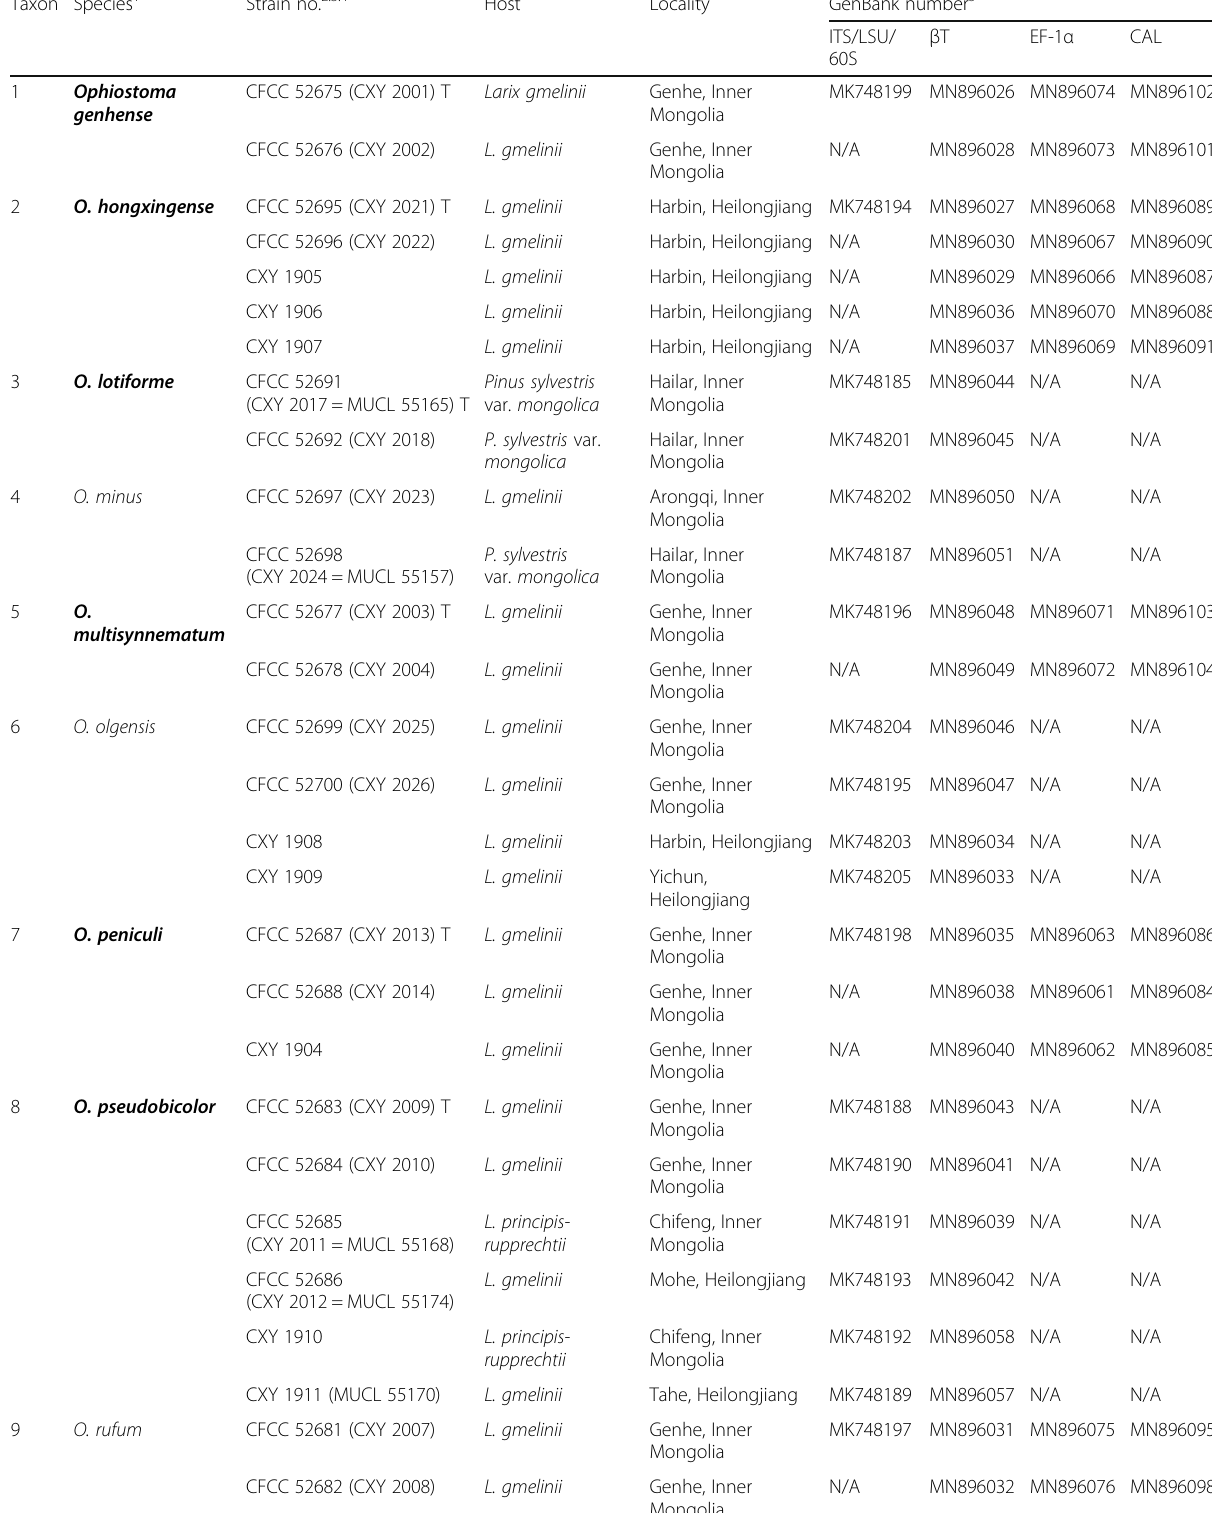
Table 1 Strains of ophiostomatoid fungi sequenced and used for morphological and phylogenetic analysis in this study Taxon Species